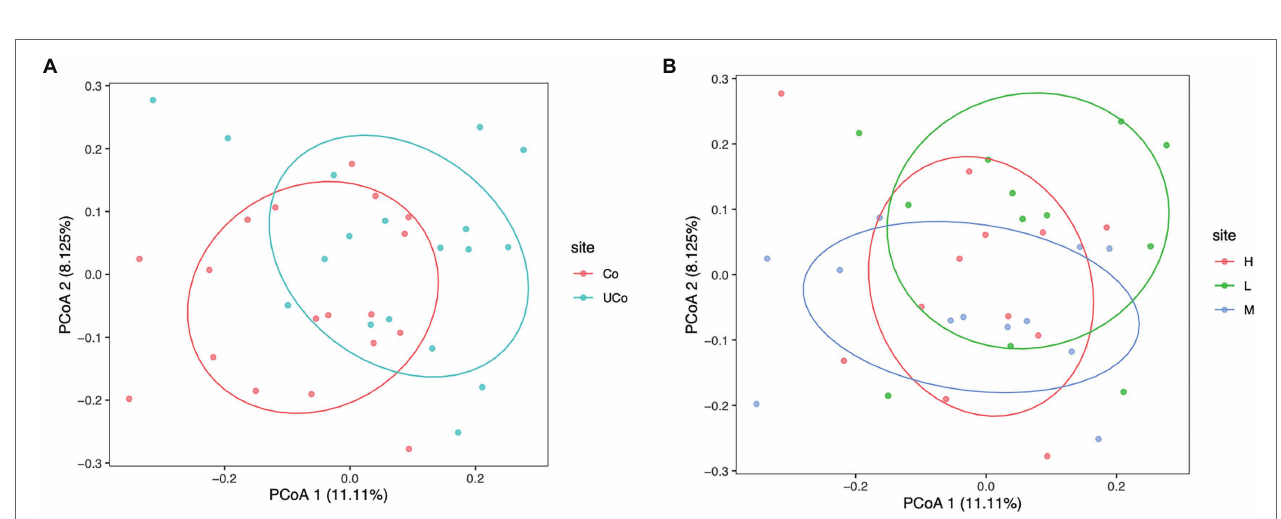
FIGURE 1 | Differentially abundant taxa between diets supplemented with different levels of coated and uncoated trace minerals. (A) Represented phylum level, (B) represented top 20 genera. Data are means of six replicates. CoL, 300 mg/kg of coated trace mineral treatment; CoM, 500 mg/kg of coated trace mineral treatment; CoH, 1,000 mg/kg of coated trace mineral treatment; UCoL, 300 mg/kg of uncoated trace minerals treatment; UCoM, 500 mg/kg of uncoated trace minerals treatment; and UCoH, 1,000 mg/kg of uncoated trace minerals